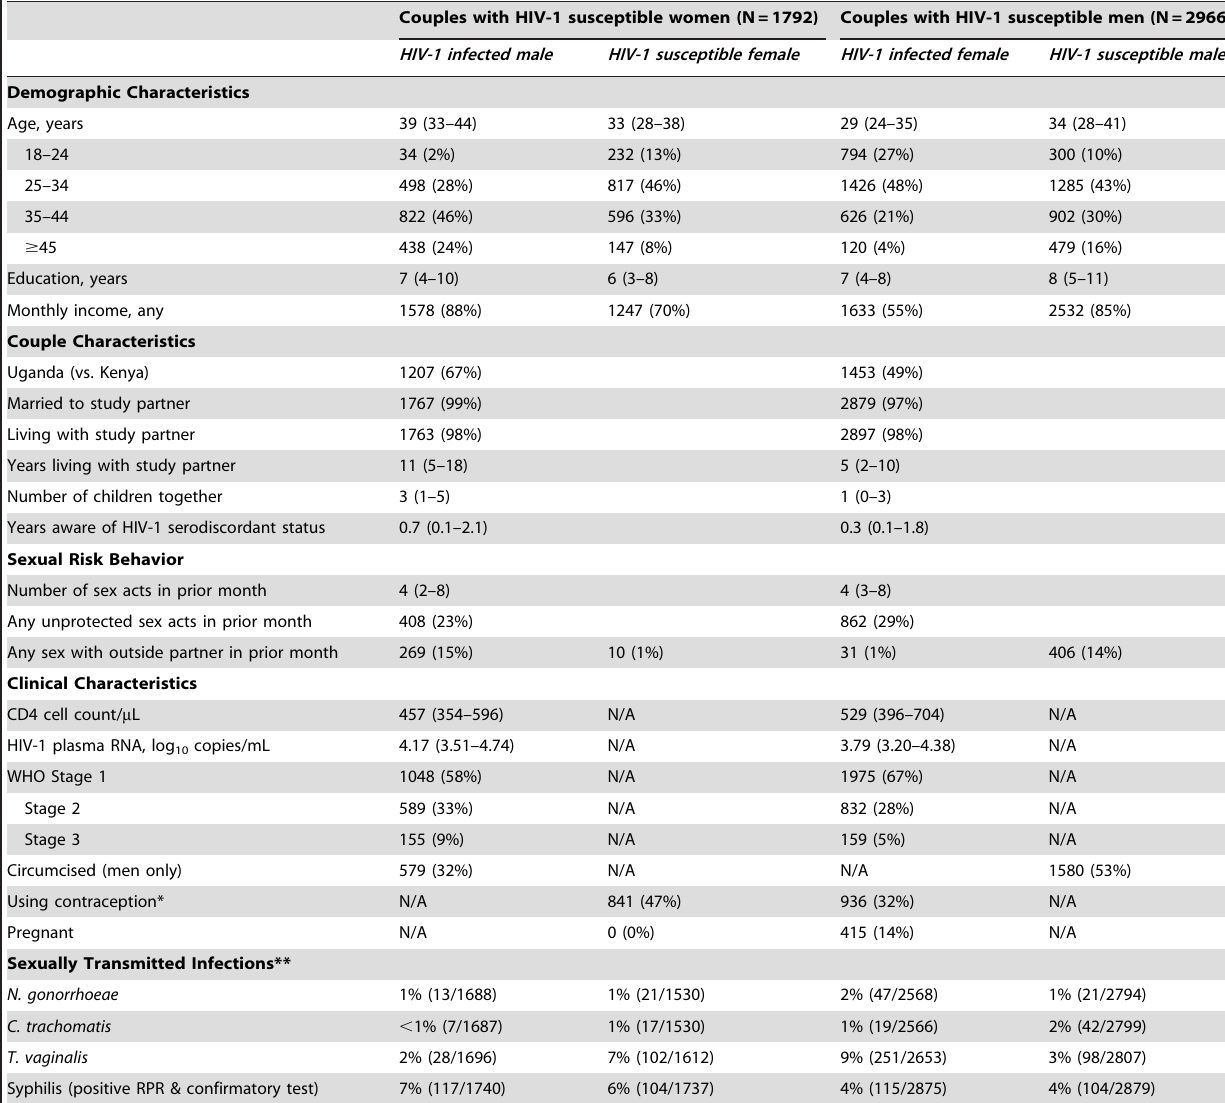
Table 3. Baseline Characteristics of Enrolled HIV-1 Serodiscordant Couples (N =4758).